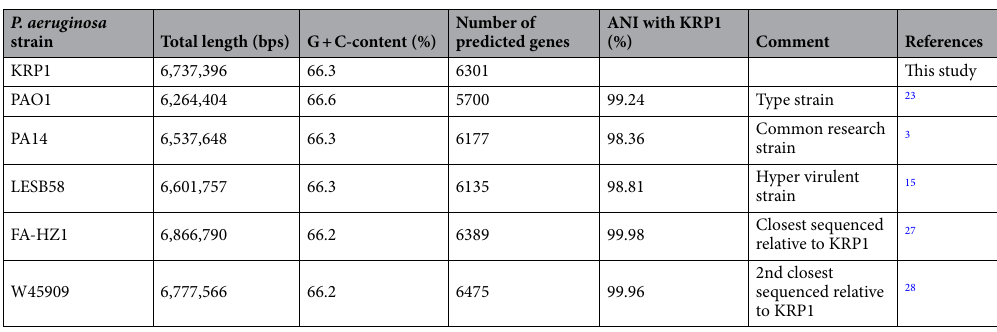
Table 1. Genomic overview of different P. aeruginosa strains used in this study. ANI analysis was performed with the EDGAR platform